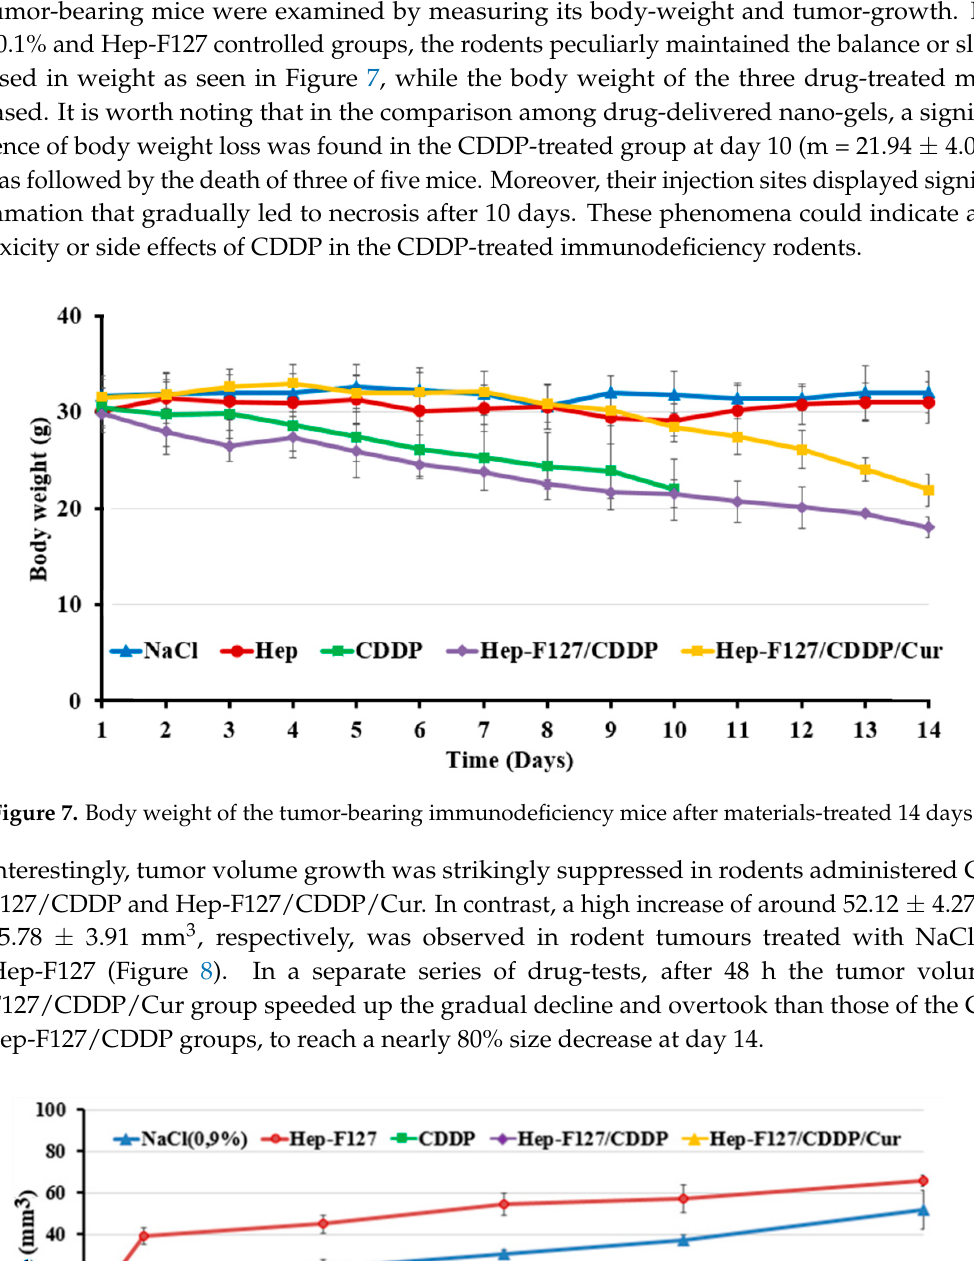
Figure 6. Tumor implanted by xenografted assay and Its characterized method: Implanted tumor before materials treatment ( a ), drug delivery system-treated tumor ( b ), SOD2 immunohistochemical staining of tumor ( c and d ).